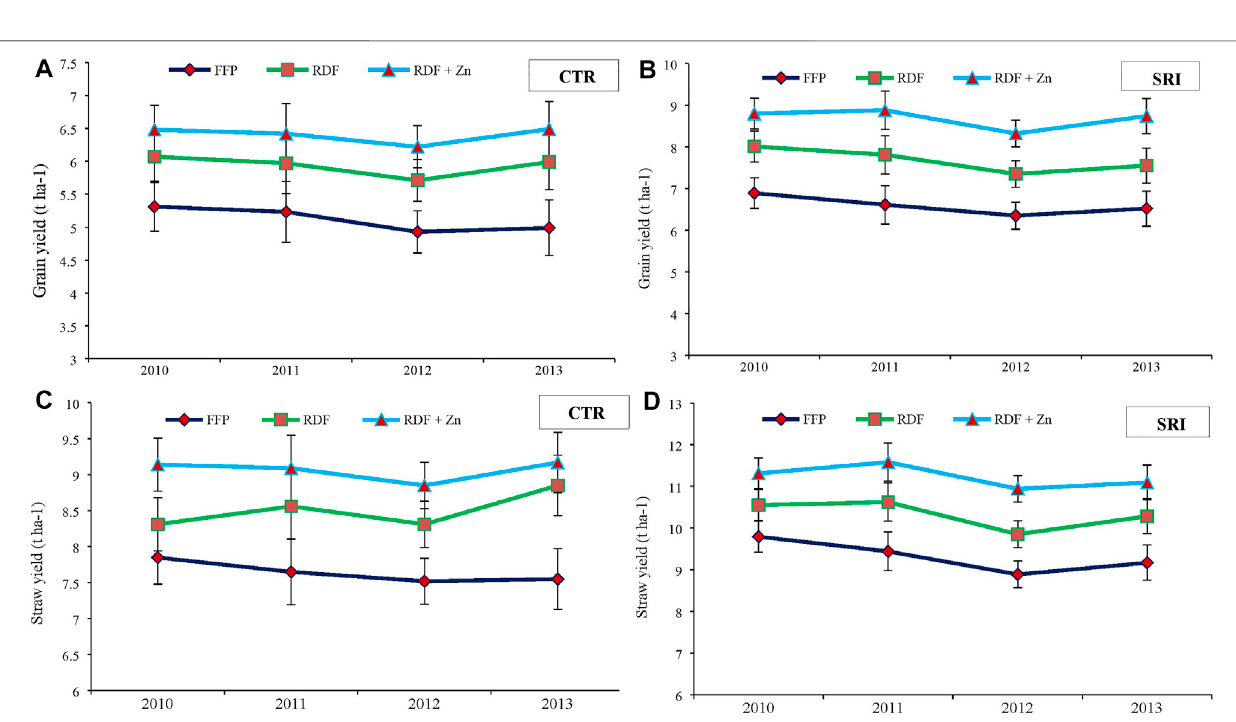
Frontiers in Environmental Science |